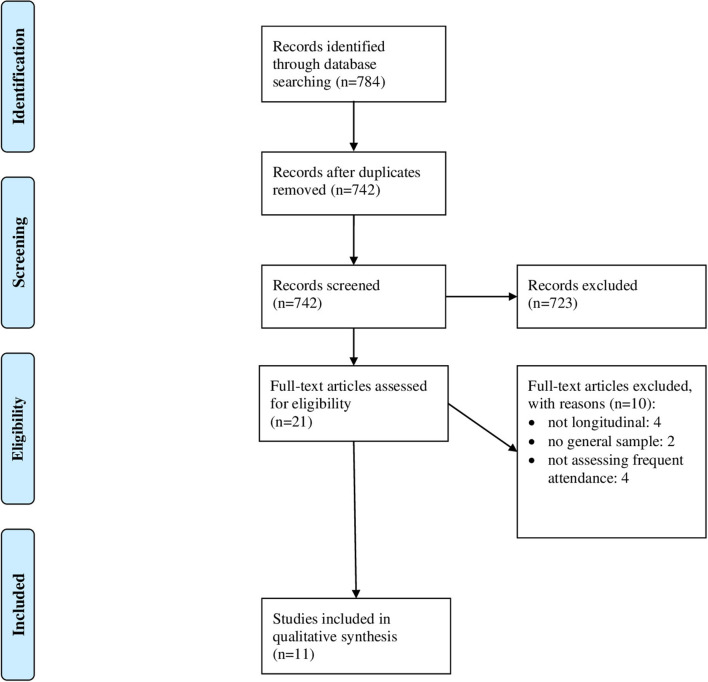
PRISMA flow diagram.